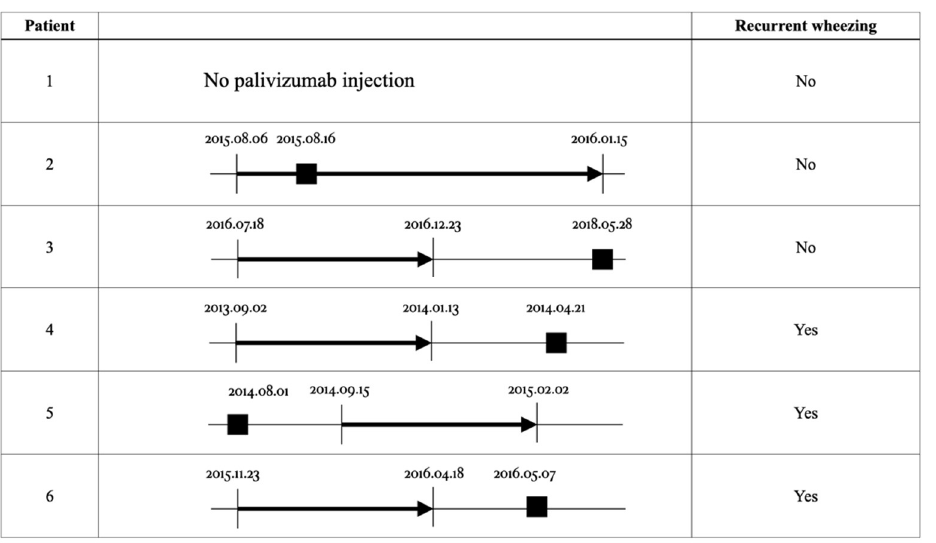
Figure 1. The course of palivizumab prophylaxis and time of RSV infection in six patients. Arrows ( ) mean the course of palivizumab prophylaxis. Black squares ( ) mean RSV infection date. RSV: respiratory syncytial virus.